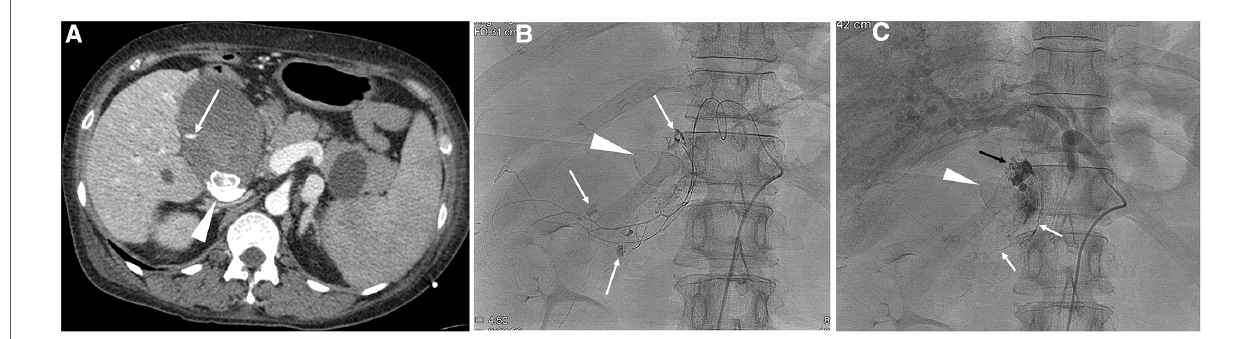
FIGURE 1 A 49-year-old female with liver cirrhosis and hemorrhagic cholecystitis. ( A ) CT scan shows extravasation of contrast media (arrow) in the gallbladder. Note gall stones (arrowhead). ( B ) Selective angiogram of the cystic artery shows multifocal extravasation (arrows) of contrast media. Note gall stones (arrowhead). A mixture of n-butyl cyanoacrylate and Lipiodol was used for embolization of the main cystic artery. ( C ) The fi nal angiogram shows cessation of active bleeding. Note glue material in the cystic artery (white arrows) and in the lumen of the gallbladder (black arrow), and gall stones (arrowhead). Development of ischemic cholecystitis occurred after embolization of the cystic artery, resulting in sepsis and multiorgan failure. The patient died three days after cystic artery embolization.